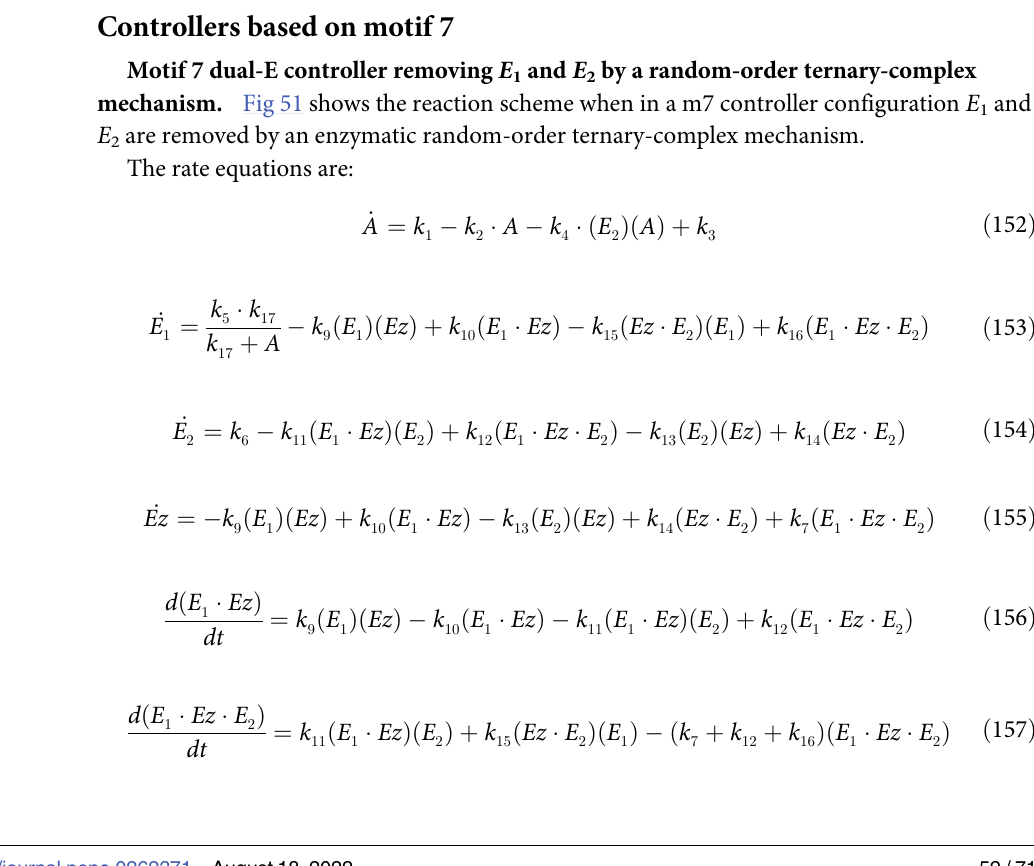
and E by a random-order ternary-complex 1 2